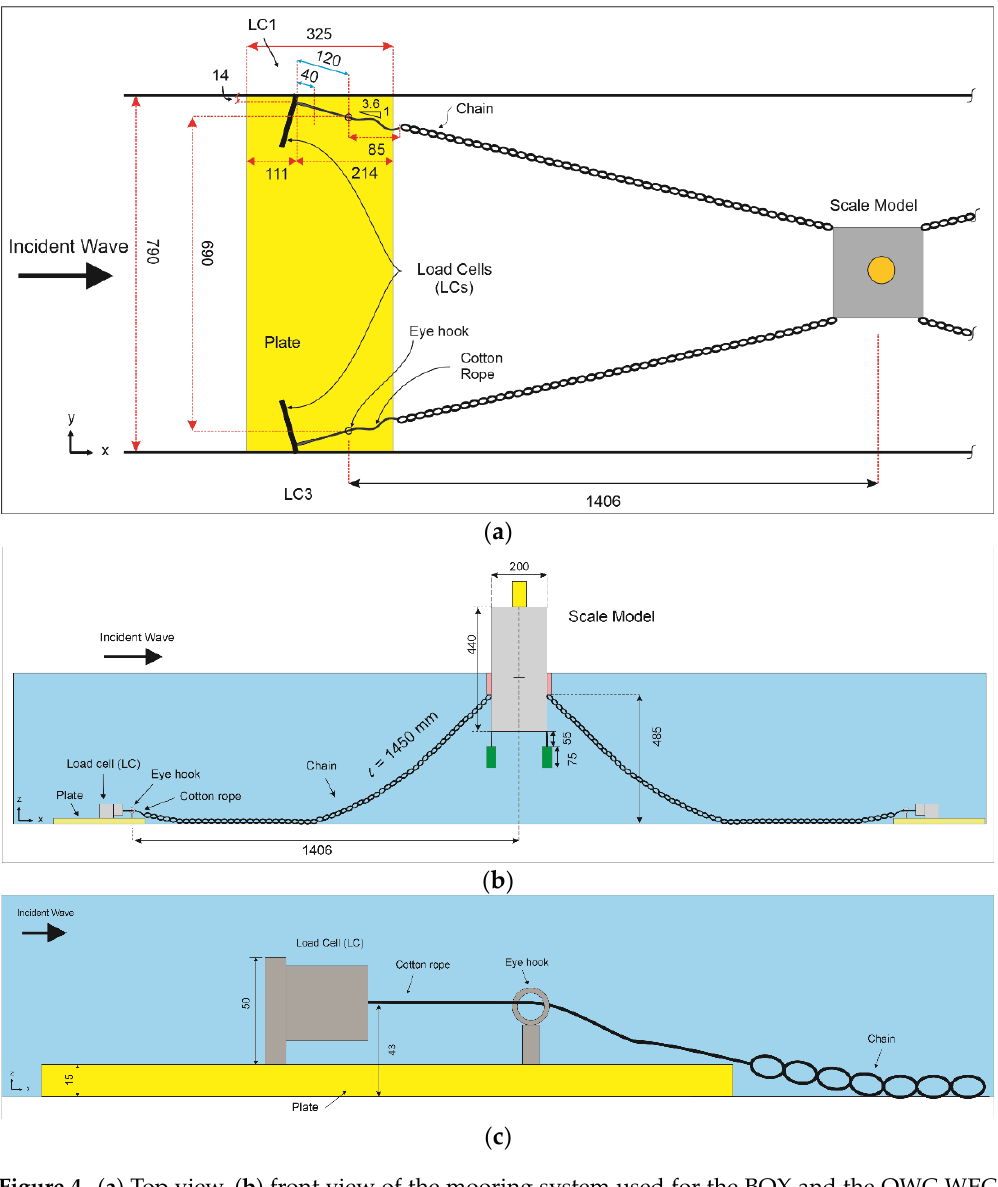
Figure 4. ( a ) Top view, ( b ) front view of the mooring system used for the BOX and the OWC WEC models, ( c ) detail of the load cell (LC) connection to the wave flume bottom (all dimensions are in mm).